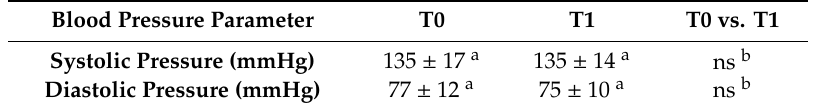
Table 5. Blood pressure parameters of CKD patients.